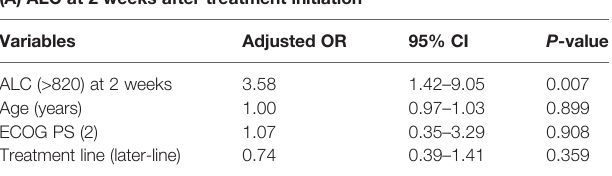
TABLE 3 | Multivariable logistic regression analyses of the early onset of immune-related adverse events. (A) ALC at 2 weeks after treatment